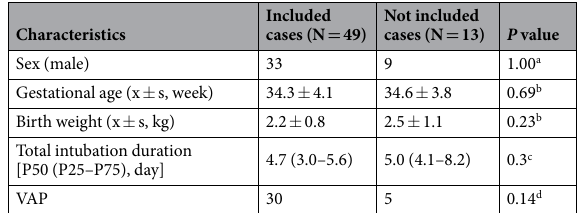
Table 1. Comparison of baseline characteristics between 49 study patients included in the study and 13 patients who were not included in the study. a Based on Fisher’s exact test. b Based on unpaired Student’s t-test. c Based on Mann–Whitney U test. d Based on Chi-square